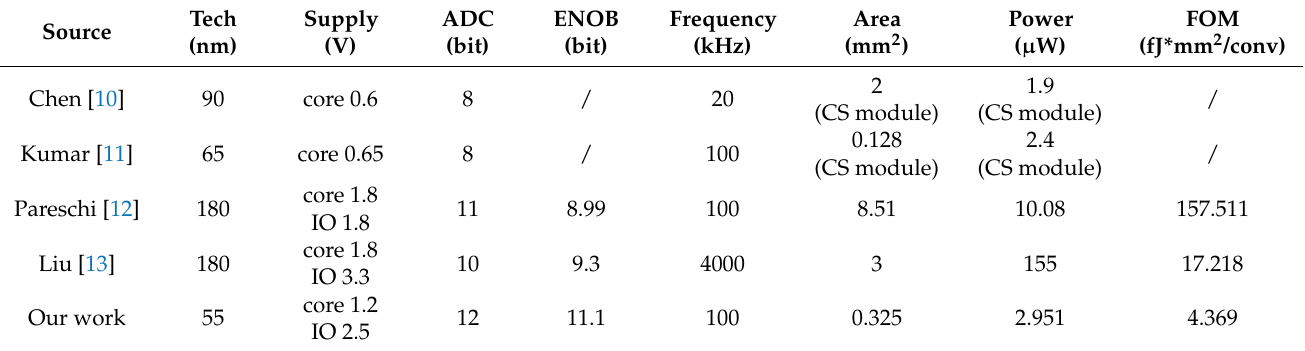
Table 4. The comparisons among different sampling and compression circuits.